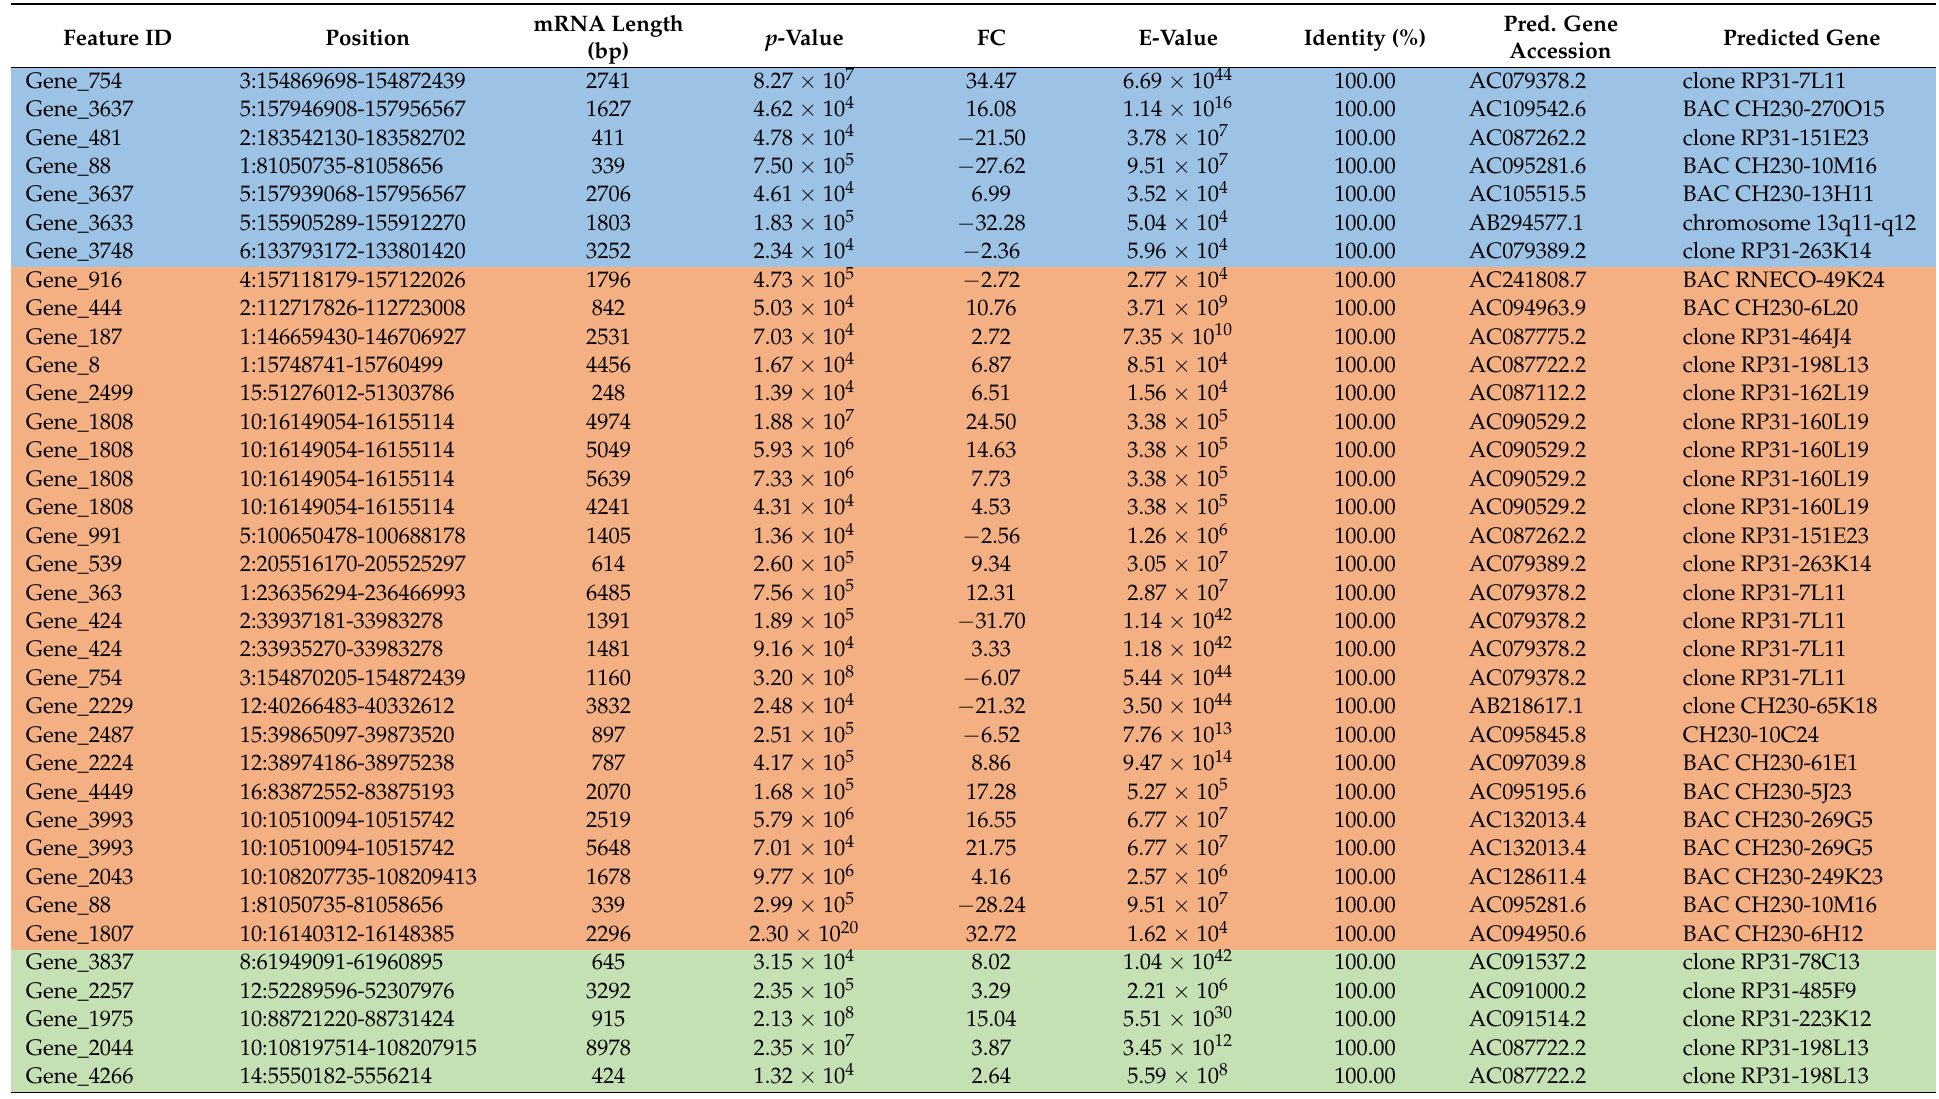
Table 4. Differentially expressed novel transcripts associated with non-annotated genes in adrenal